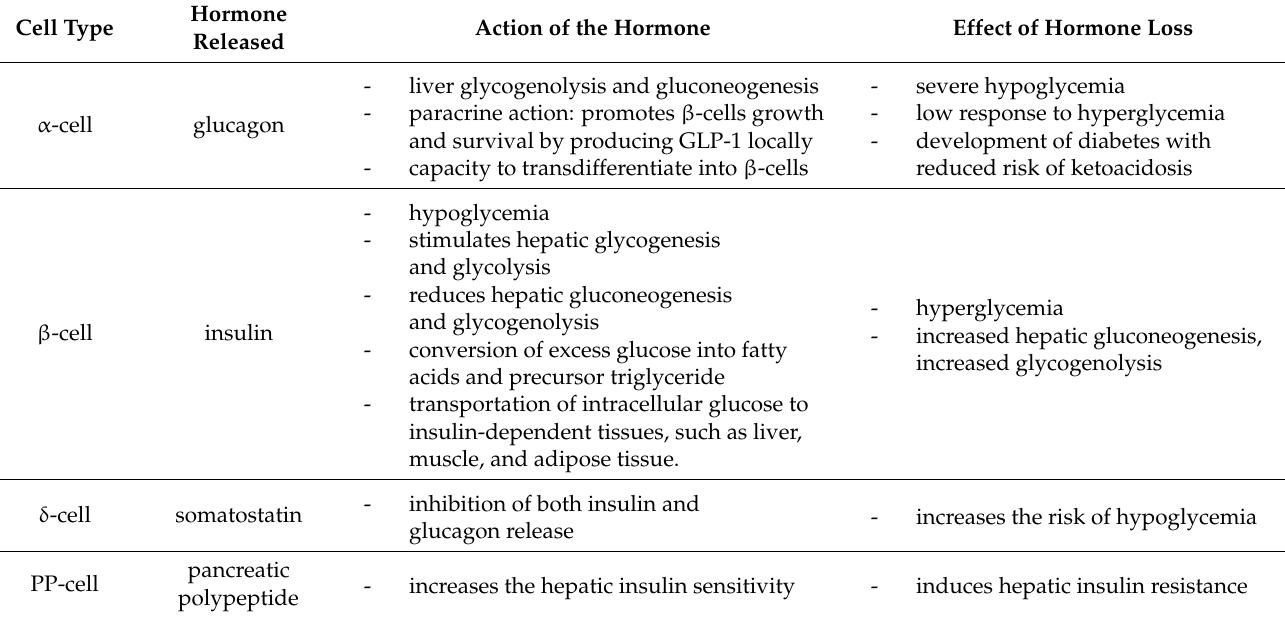
Table 1. Hormones secreted by the islet of Langerhans cells and the effects of their loss on glucose homeostasis